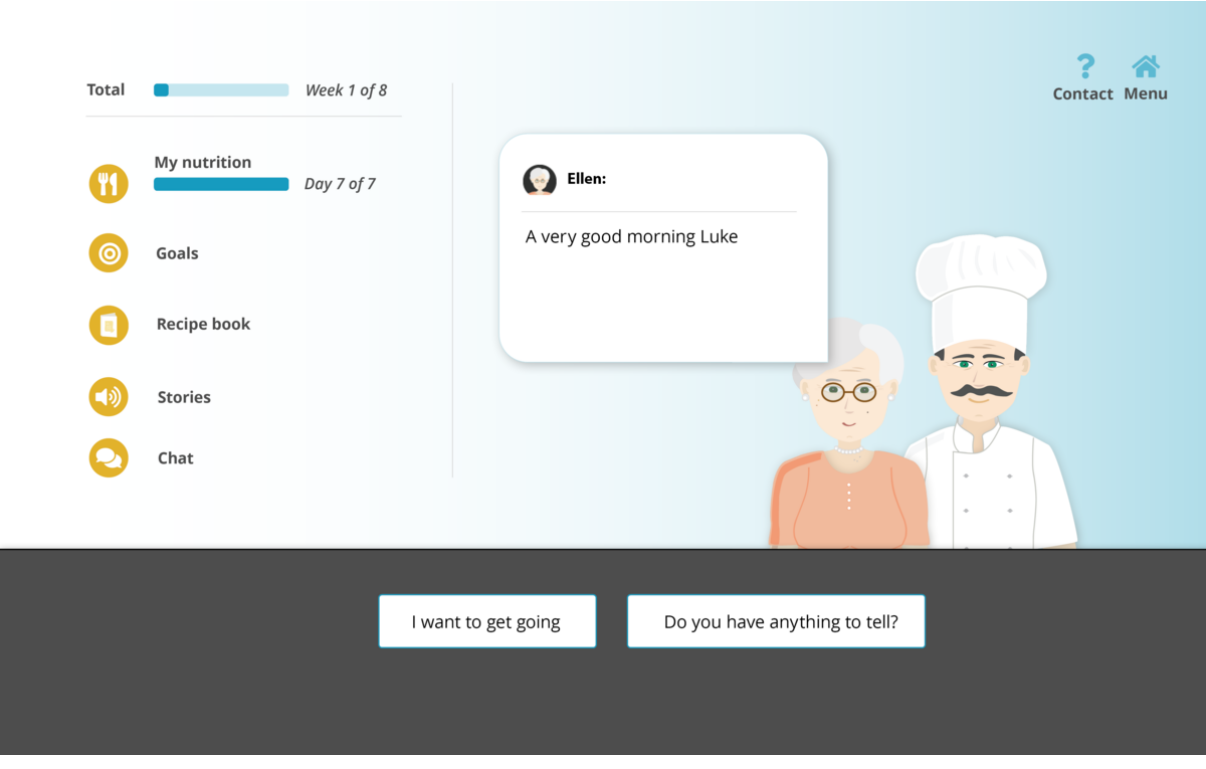
Figure 4. PACO app home screen.